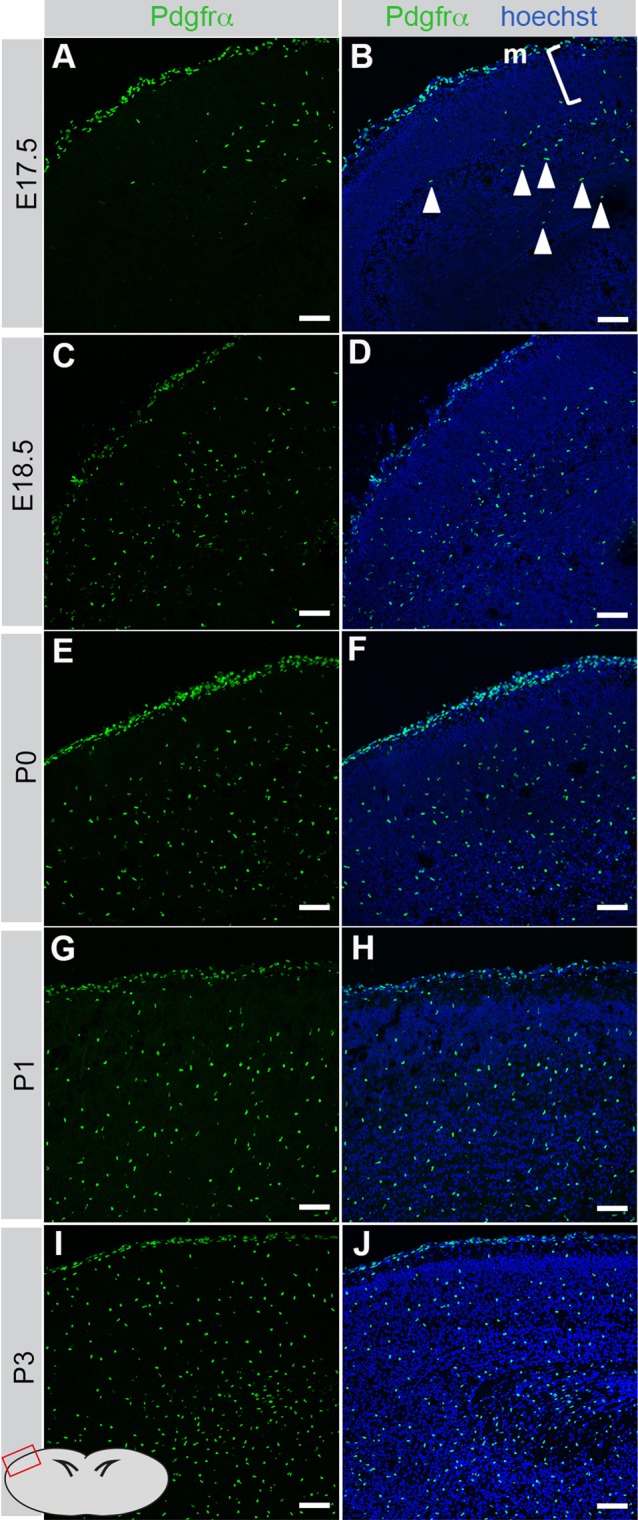
Meningeal expression of PDGFRα in cerebral cortex. Coronal sections from PDGFRαGFP/+ mice at E17.5 to P3. Illustration in lower left corner shows where the photos are taken. The majority of PDGFRα-GFP expressing cells were in the meninges (m) whereas very few cells were located in the underlying zone (marked [). Day by day, PDGFRα-positive oligodendrocyte precursors (arrowheads) populate the parenchyma. Scale bar: 60 µm.